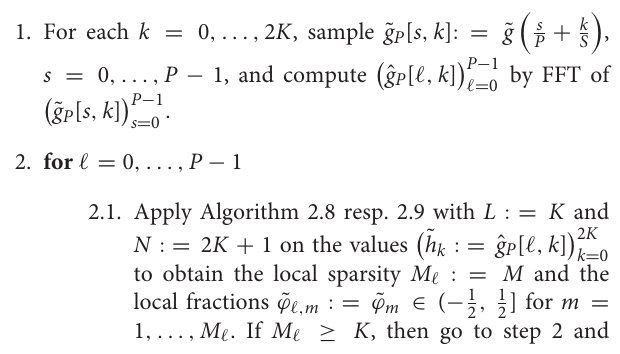
Algorithm 3.2 (Sparse FFT via MUSIC resp. ESPRIT, see Algorithm 6.1 for detailed listing with extended parameter